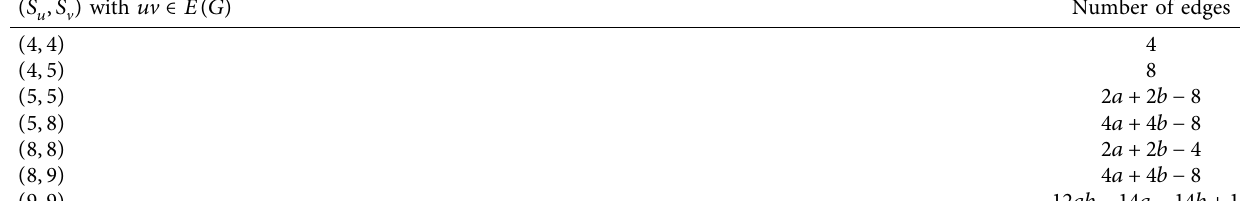
Table 7: Edge partition of T 1 [ a,b ] for neighborhood degree-based